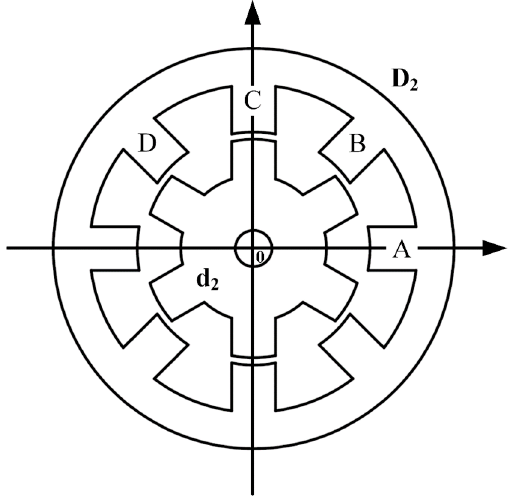
Figure 3. Analyzed cross-section of the motor.